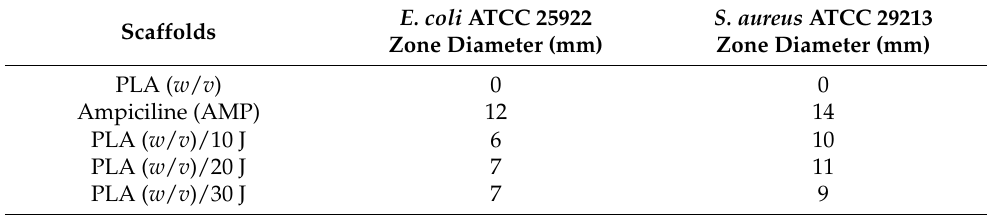
Table 2. Antimicrobial results of the PLA and PLA/J